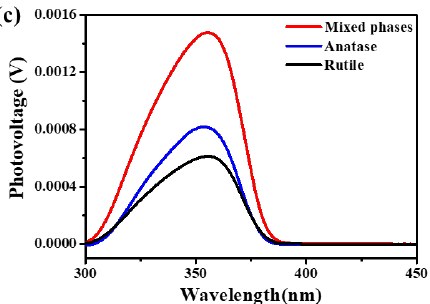
Figure 2. ( a ) De of ATL under different samples, ( b ) Pseudo- first-order model of ATL degradation. ( c ) the SPS test of anatase, rutile and mixed phase. Effect of nano-TiO 2 photocatalyst crystal phase on ATL degradation, with an initial ATL concentration of 18.77 µM and TiO 2 (anatase, rutile and mixed phase) concentration of 2.0 g/L; pH 7.6; Temperature 20 °C.